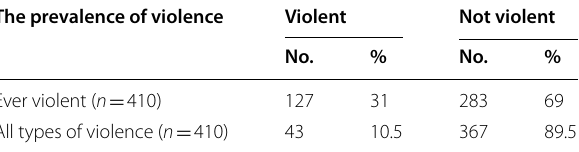
Table 1 Socio‑demographic characteristics of the